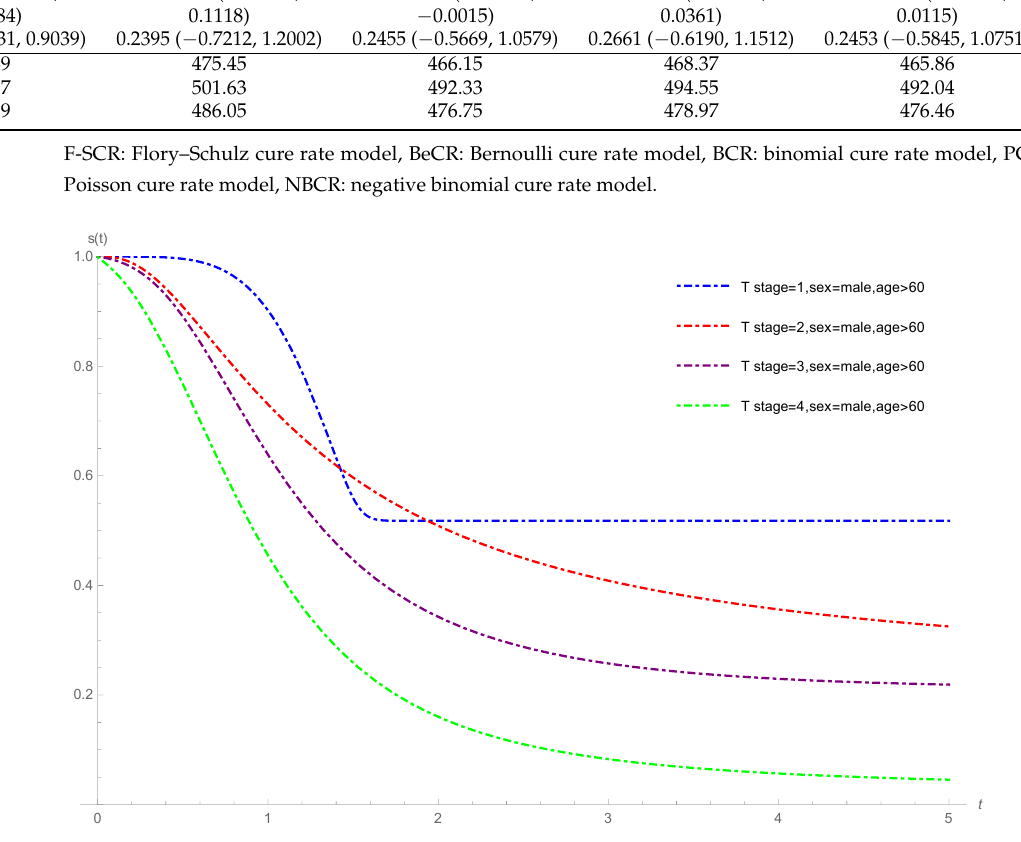
Figure 8. Plots of the survival functions for the oropharynx cancer data based on F-SCR/GeTNH model stratified by T stage (1 to 4); sex: male; age: greater than or equal to 60